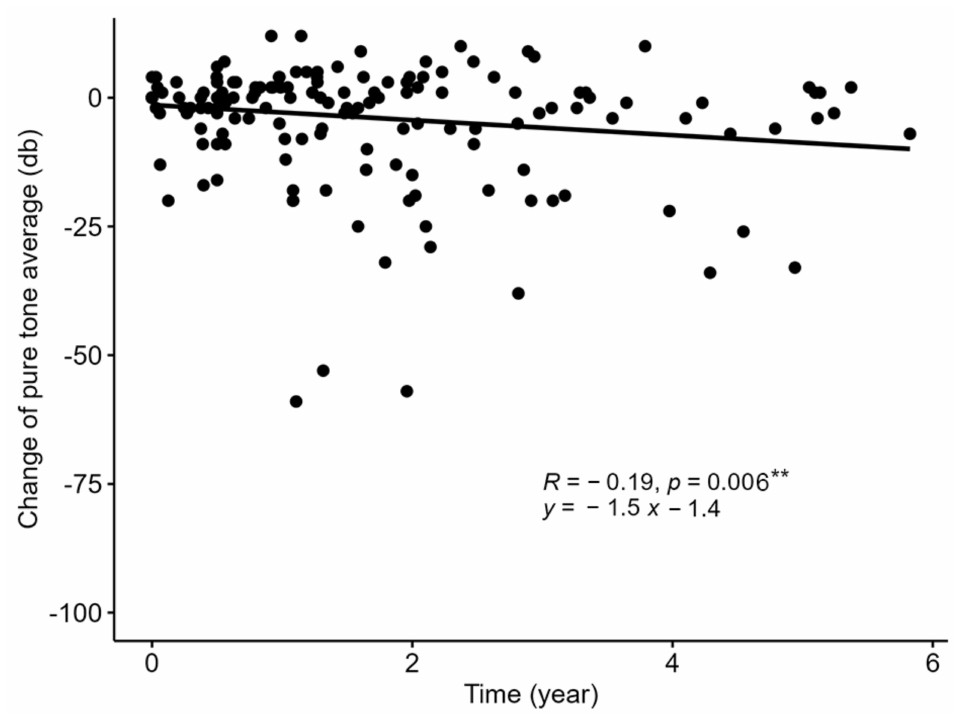
Figure 3. The sequential changes in hearing level in patients with negative genetic testing results. The prognosis for patients with negative genetic testing results was highly variable but a deteriorative tendency was still observed. ** p <